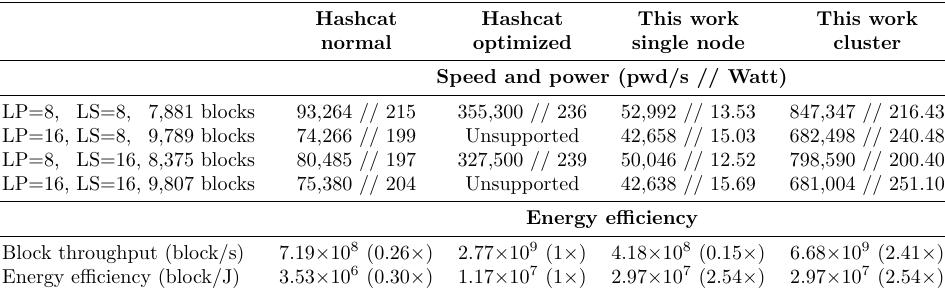
Hashcat Hashcat This work This work normal optimized single node cluster Speed and power (pwd/s // Watt)